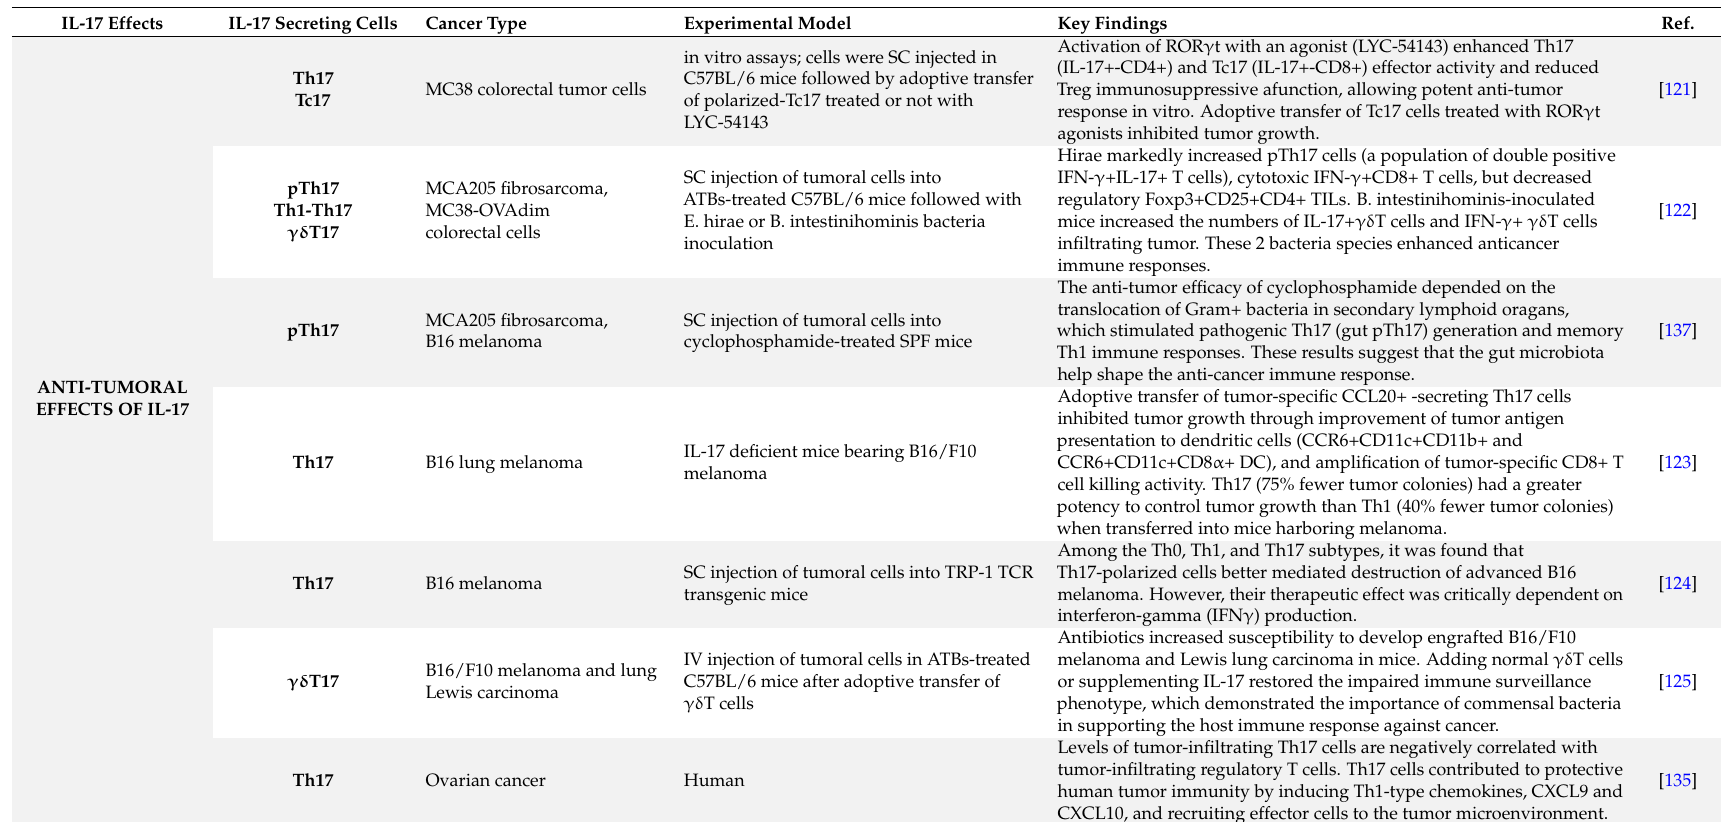
Table 1. IL-17-secreting cells: pro- or anti-tumoral activity? This table highlights different studies in which IL-17-secreting cells were associated with either anti- or pro-tumoral